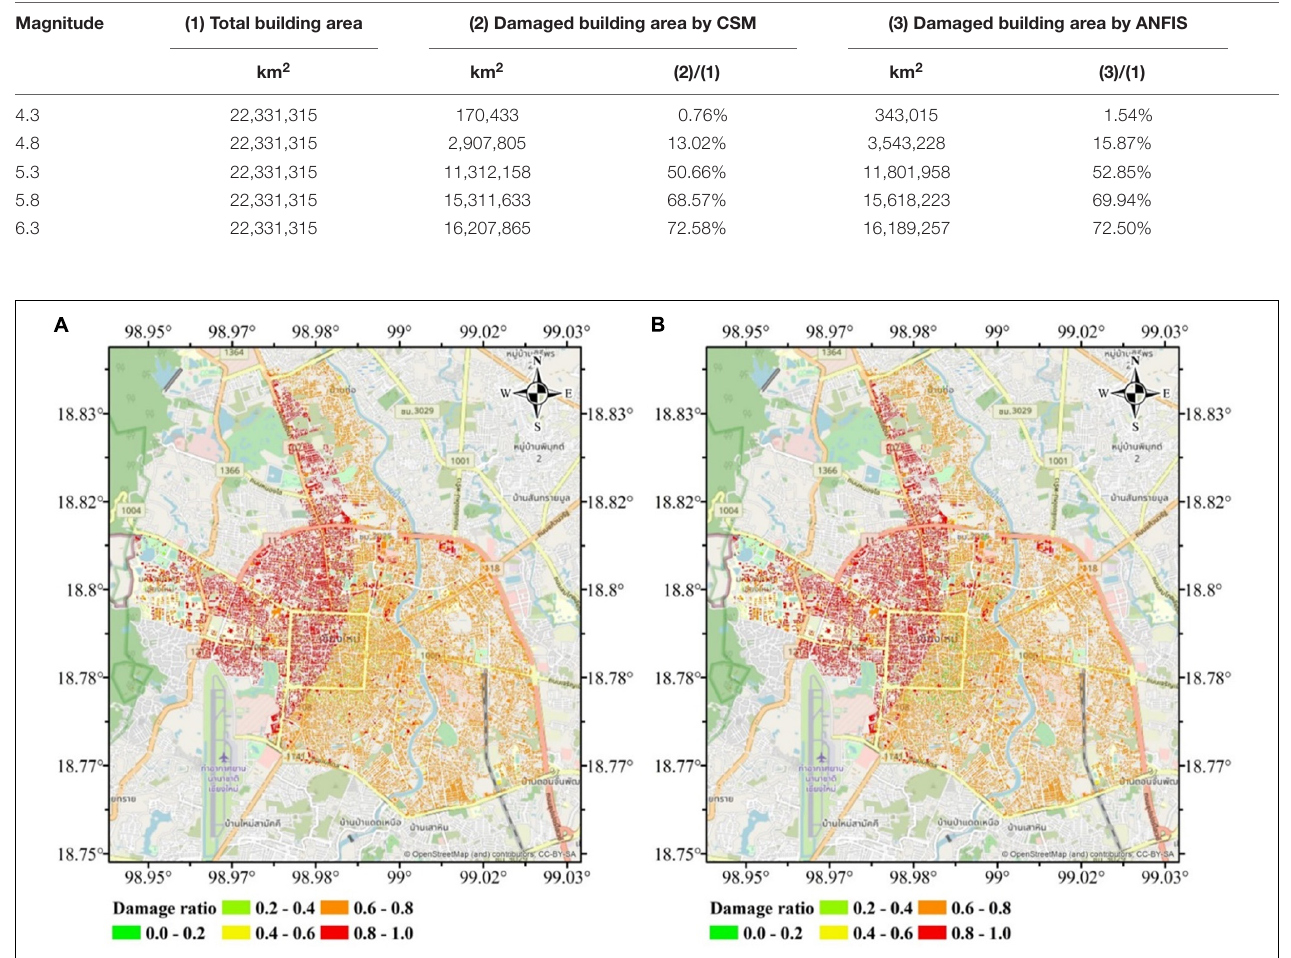
FIGURE 8 | Damage ratio of complete damage of buildings under the assumed Mw 6.3 earthquake. (A) by CSM; (B) by the proposed ANFIS model.